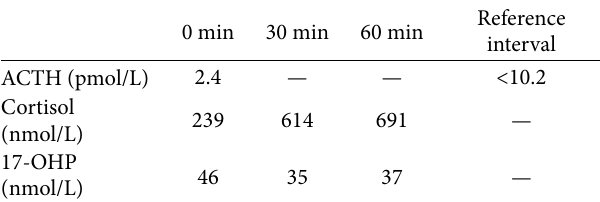
Table 2: ACTH (Synacthen) stimulation test.